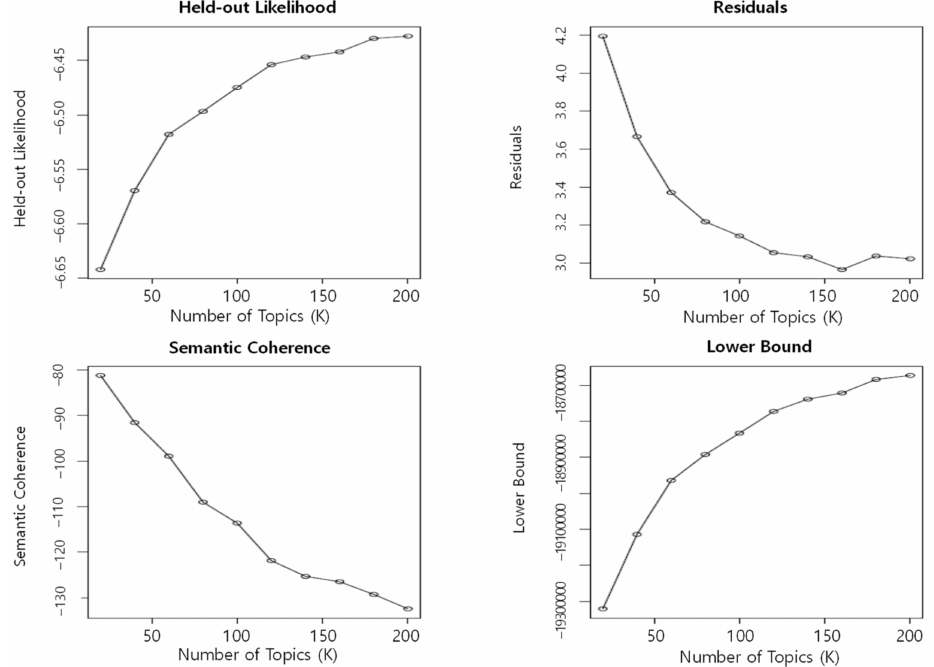
Figure 3. Diagnostic values by number of